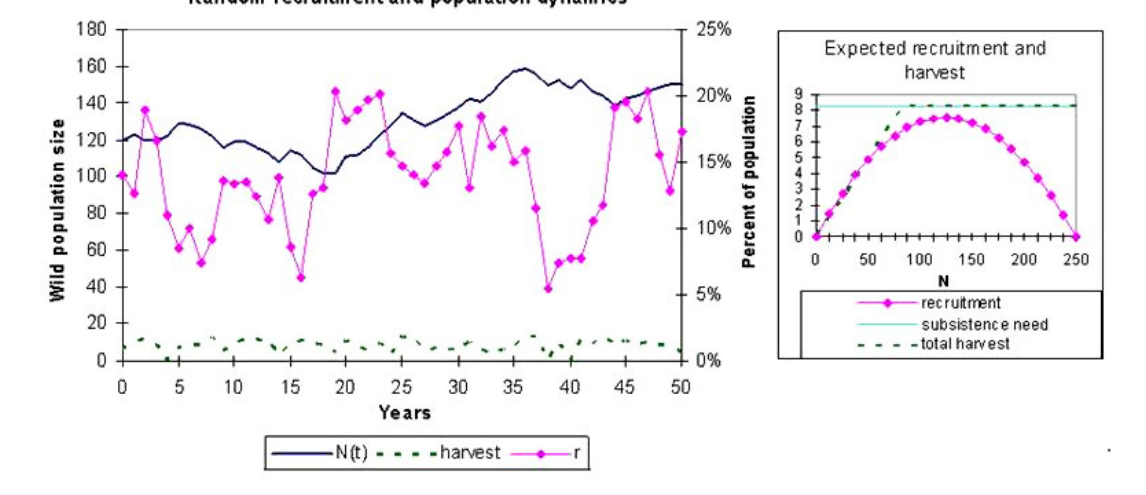
Fig. 4. Dynamics of a hunted wild Rangifer population, N (left axis), with autocorrelated random, density- dependent recruitment r (right axis). In this example, K = 250, mean r = 12% of N, with coefficient of variation = 0.3 and autocorrelation r = 0.7; mean harvest = 8.25, with coefficient of variation = 0.5 and upper limit 10% of N. Right panel illustrates nonrandom density-dependent recruitment with r = 8.25 and harvest =